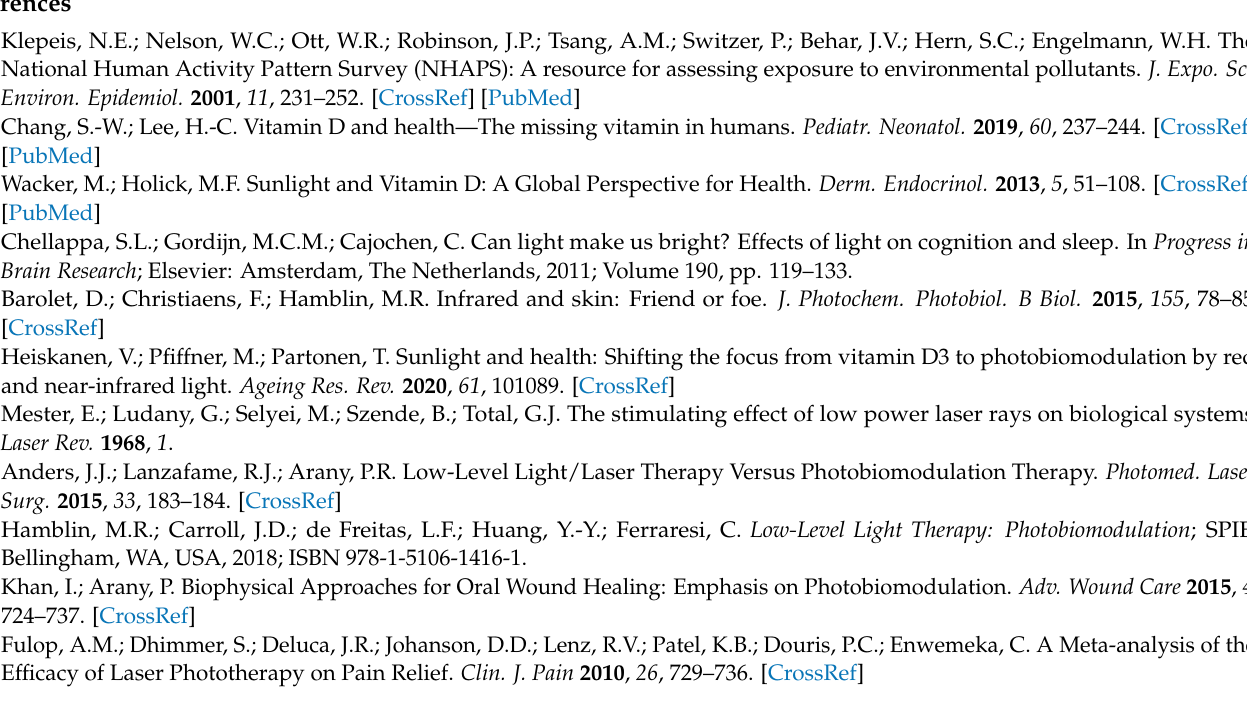
Table S2: Linear model long-term effects overview; Table S3: Linear model no long-term effects overview; Table S4: Linear model short-term effects overview; Table S5: Linear model including BMI interaction overview; Table S6: Overview of number of reported complaints throughout the study. Figure S1: Raw data well-being; Figure S2: Raw data health; Figure S3: Raw data sleep; Figure S4: Ambient light and vitamin D; Figure S5: Depression scores; Figure S6: Skin